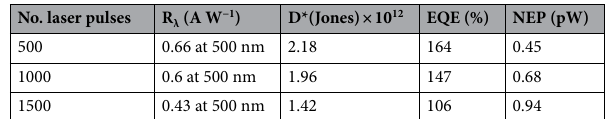
Table 3. Figures of merit of the photodetectors fabricated with different laser pulses at 500 nm.